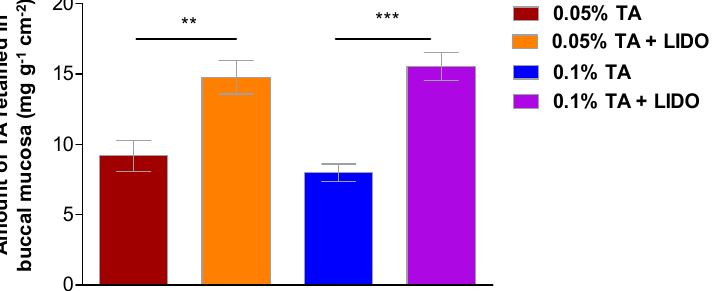
Figure 7. Amount of TA retained per gram and square centimeter of buccal mucosa, 6 h after application of each formulation (0.05% TA or 0.05% TA + LIDO, or 0.1% TA or 0.1% TA + LIDO). Values represent Mean ± SEM ( n = 5). Statistical differences ** ( p < 0.01), *** ( p < 0.001).